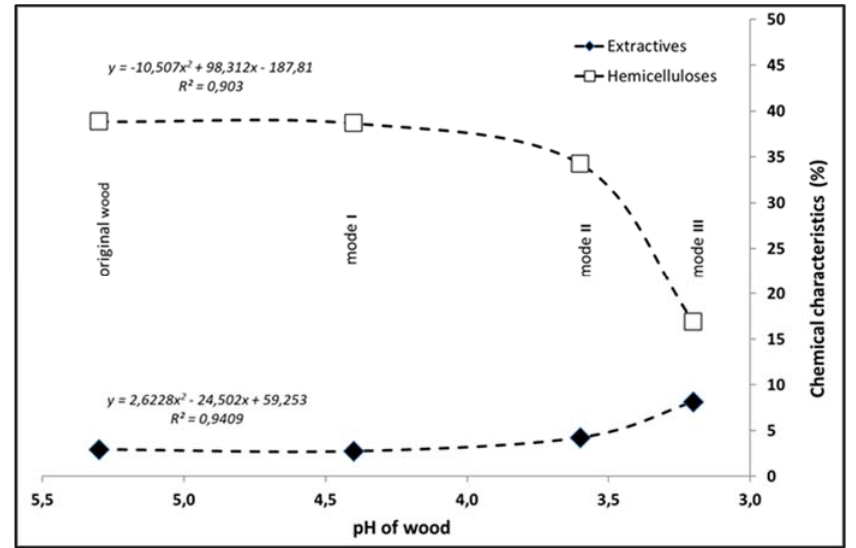
Figure 5. Dependence of select chemical characteristics on pH.